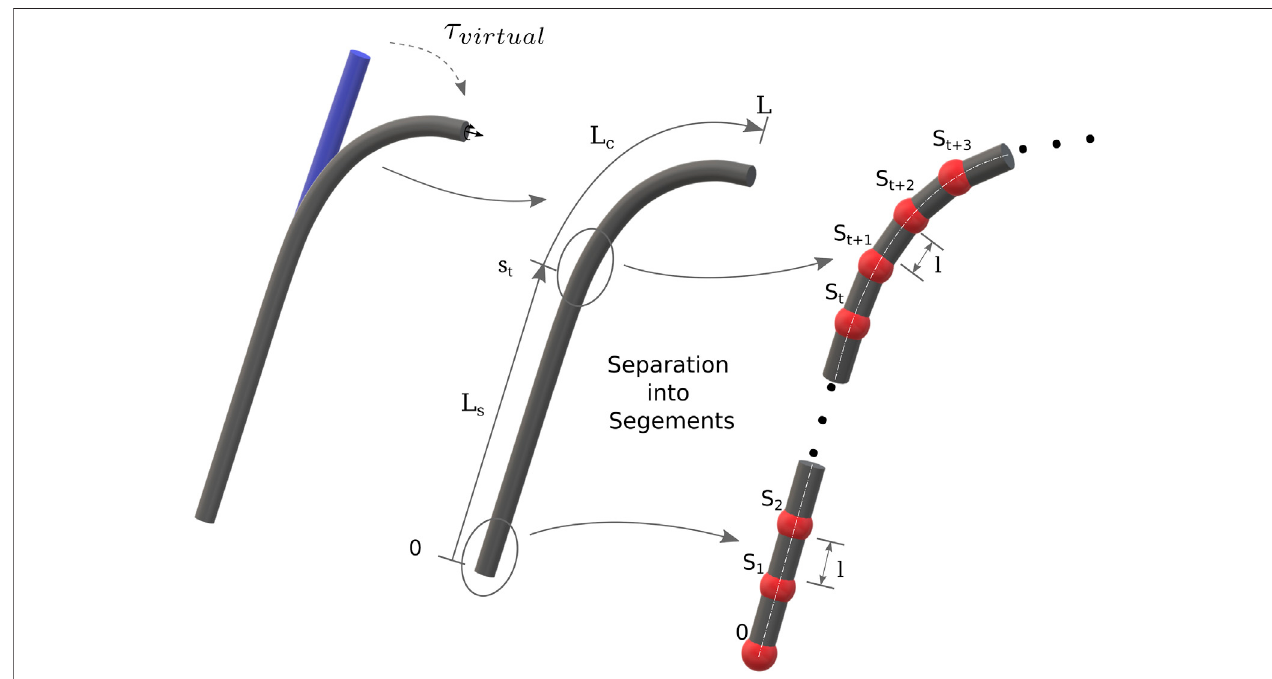
FIGURE 2 | Initially, all tubes (also nested) are considered as straight and the pre-curvature is accounted as virtual loads. Each tube is divided into a straight and a curved segments. The m segments are discretized into n sections of length l .